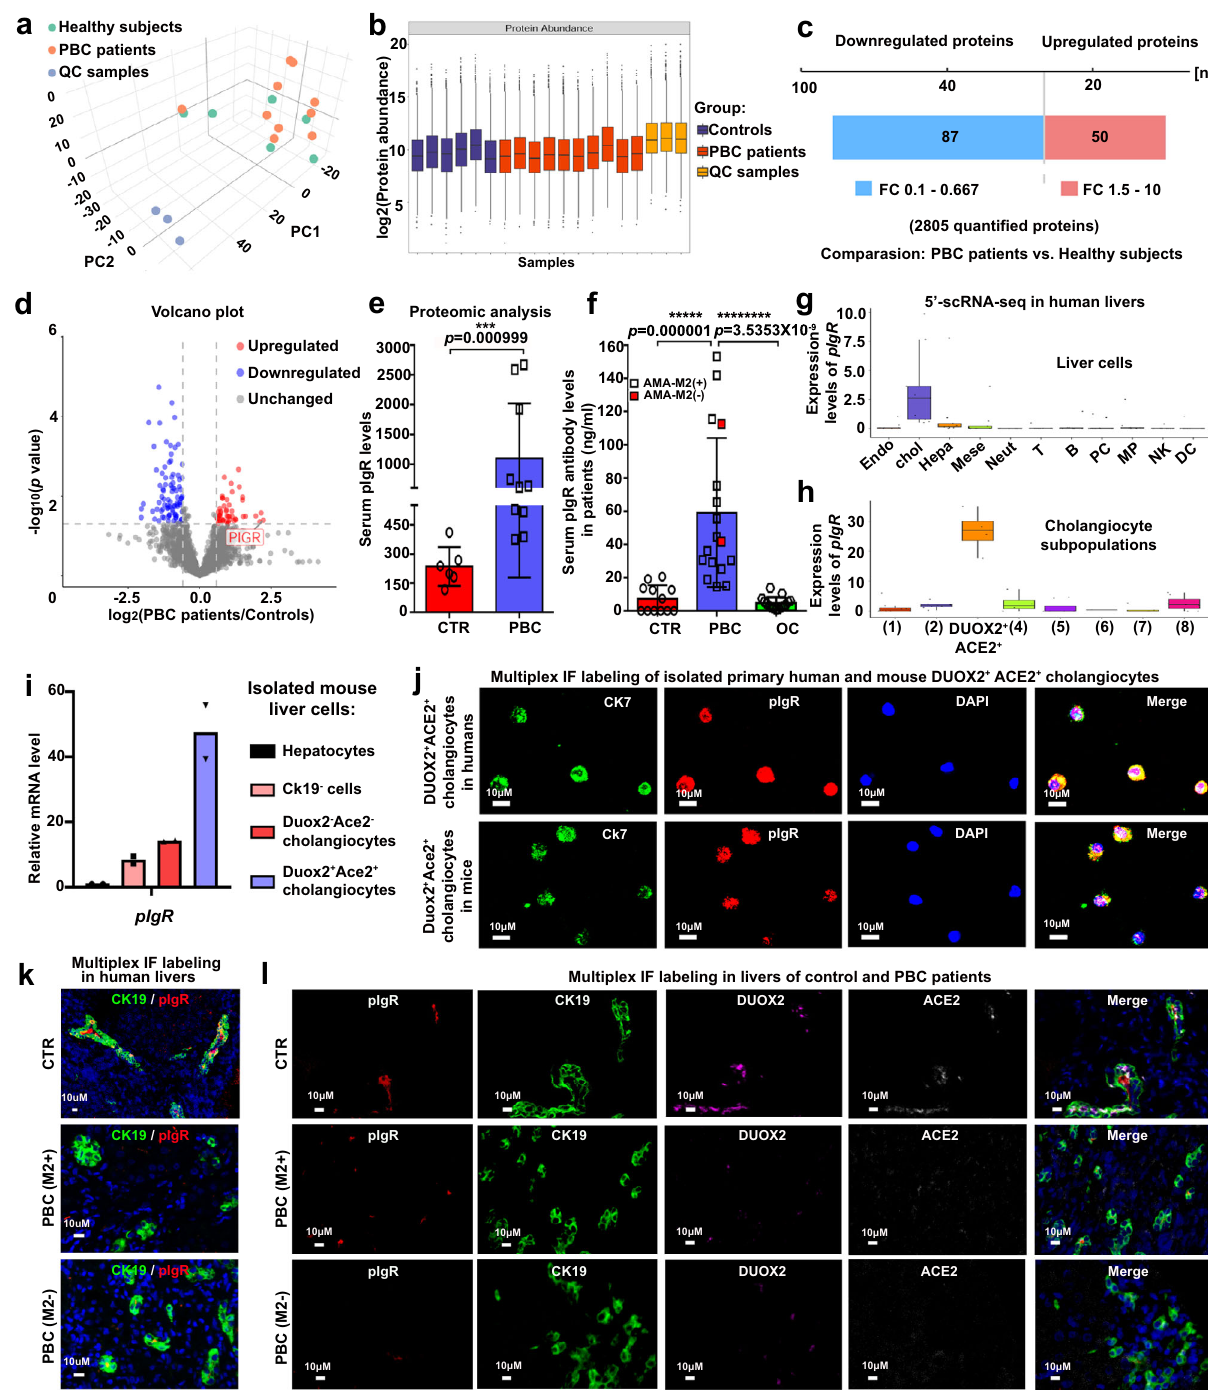
Fig. 5 | Interactions between DUOX2 + ACE2 + small cholangiocytes and immune cells or cholangiocytes in the cluster (1) and (2). a Cell-cell interaction networks predicted the potential interaction magnitude between cholangiocytes in the cluster (3) (named DUOX2 + ACE2 + small cholangiocytes) and different types of immune cells in control and PBC livers ( n =4 and n =5, respectively). Line thick- nesses denote the numbersofligand-receptorpairs. MP mononuclearphagocytes, NK cells natural killer cells, DCs dendritic cells. b Heatmap displayed the total numbersofligand-receptorpairsbetweenDUOX2 + ACE2 + smallcholangiocytesand differenttypesofimmunecells. c Dotplotexhibitedthesigni fi cantligand-receptor pairs involvedin the interactions betweenDUOX2 + ACE2 + smallcholangiocytesand different types of immune cells. Ligand and cognate receptors are shown in the y axis;cellpopulationsthatexpressligandandreceptorareshowninthe x axis.Circle